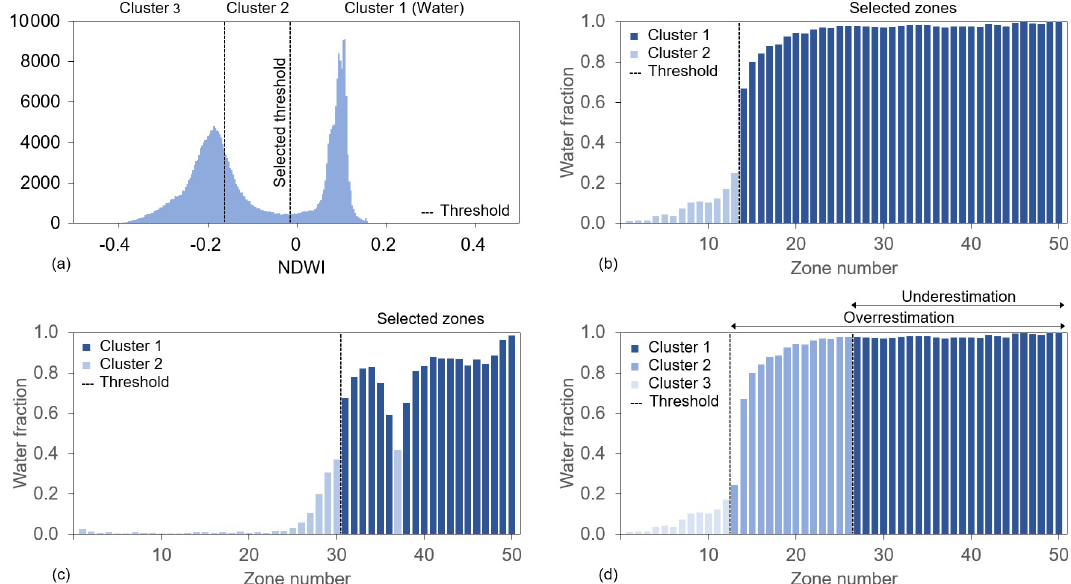
Figure 6. Illustration of the k -means classifications used in Step 2.3 and 2.5. Panel (a) shows the water pixels classification based on NDWI values (Step 2.3), while panels (b, c) show the identification of additional water zones based on two clusters (Step 2.5). Panel (d) illustrates the issues that arise when using three clusters in Step